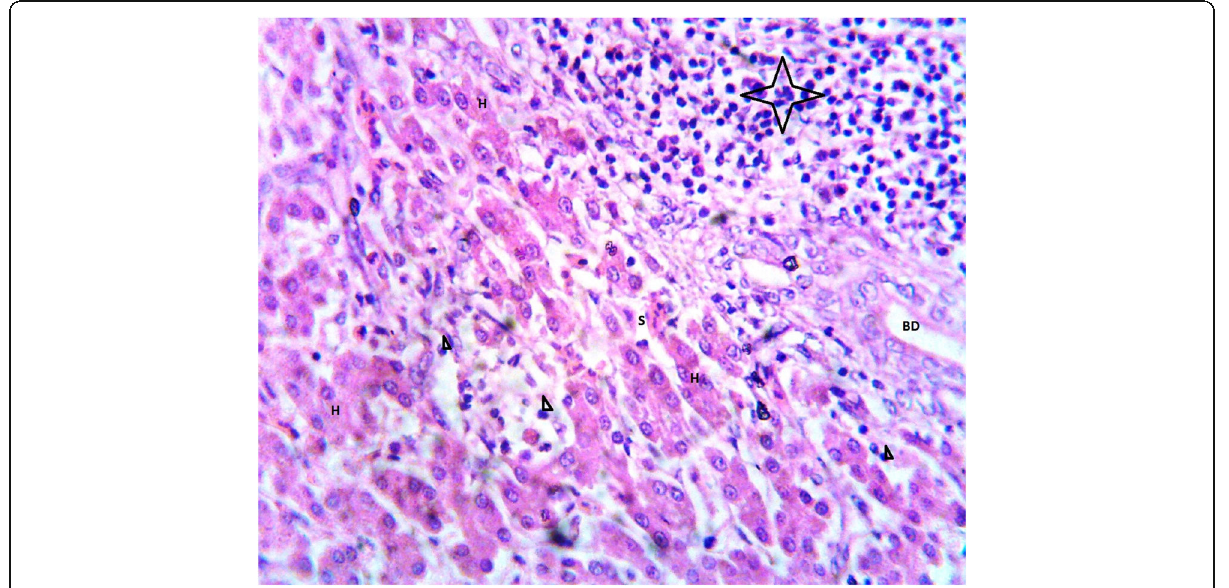
Fig. 4 Representative micrograph of liver section (× 400) of broiler chicks fed 0.6% PCM supplemented diet. This section shows the proliferation of polymorphonuclear and mononuclear cells (arrow and star), activation of liver macrophage system the Kupffer cells